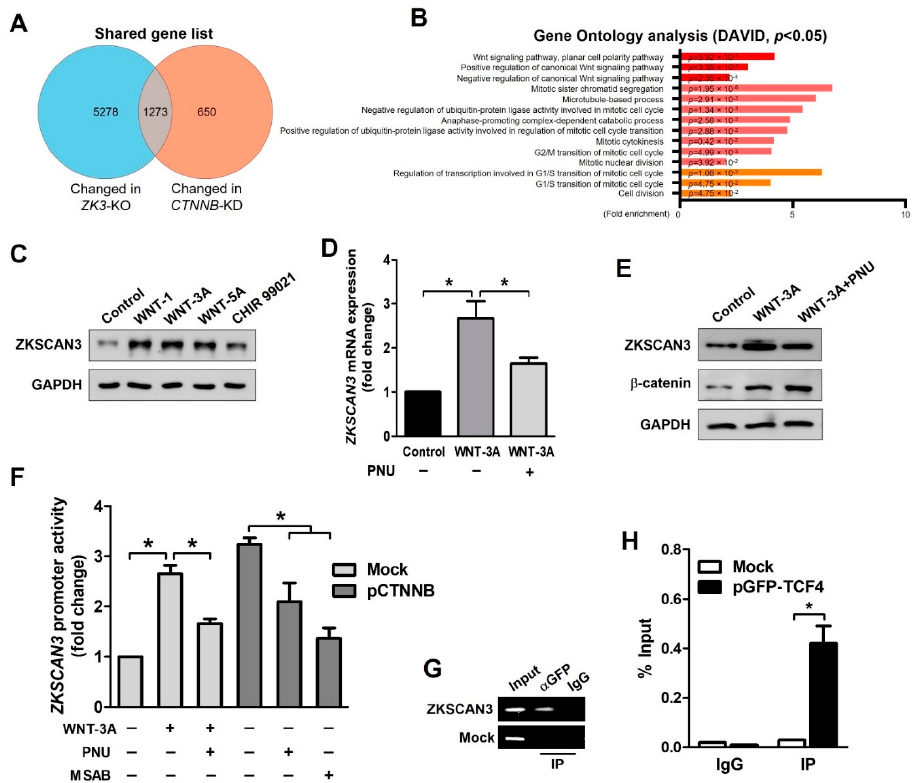
Figure 3. WNT signals upregulate ZKSCAN3 transcription through a β -catenin-dependent pathway. ( A ) Venn diagram comparing the DEGs of ZK3-KO cells with previously reported results using the CTNNB1-KD HCT116 cell line. ( B ) GO analysis using selected genes, which were altered in both the RNA sequencing results. p -values are indicated. ( C ) HCT116 cells were treated with WNT-1 (50 ng/mL), WNT-3A (100 ng/mL), WNT-5A (50 ng/mL), or CHIR 99,021 (3 µ M) for 24 h, and cell lysates were subjected to Western blotting using the indicated antibodies. (D, E) HCT116 cells were treated with WNT-3A (100 ng/mL) for 24 h in the presence or absence of 40 µ M PNU and cells